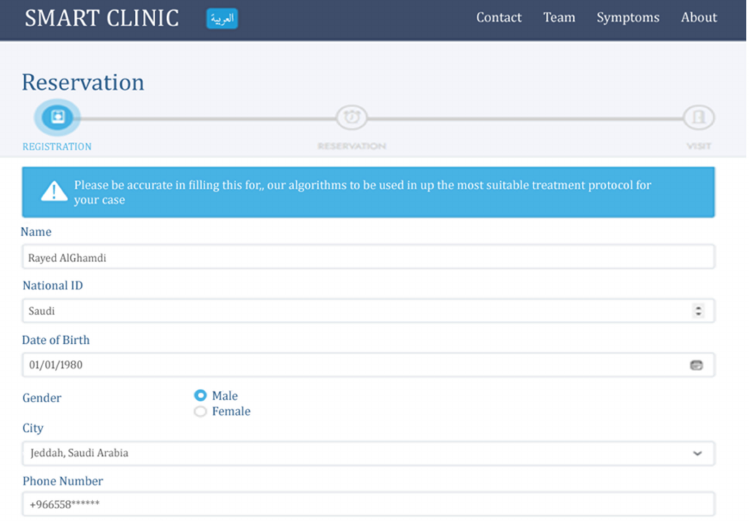
Figure 5. The registration